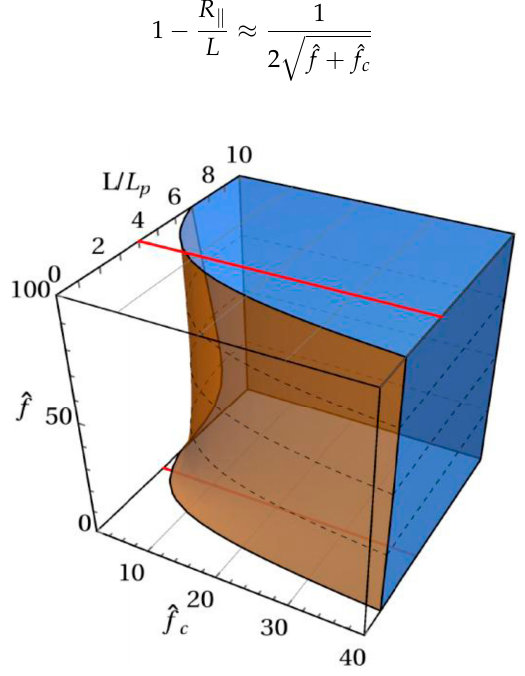
ˆ f L L . Figure 2. Dependence of the range 0.98 < ε < 1.02 on ˆ f , ˆ f f , and / , ˆ c , and L / L p p c